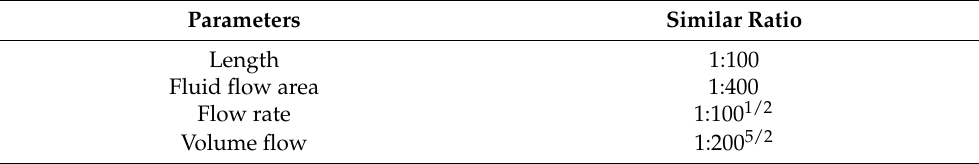
1:100 1:400 1:100 1/2